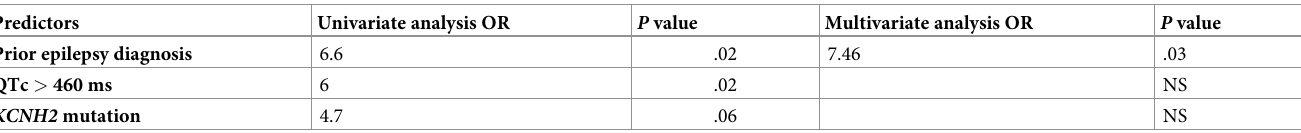
Table 3. Univariable and multivariable predictors. QTc: corrected QT interval.